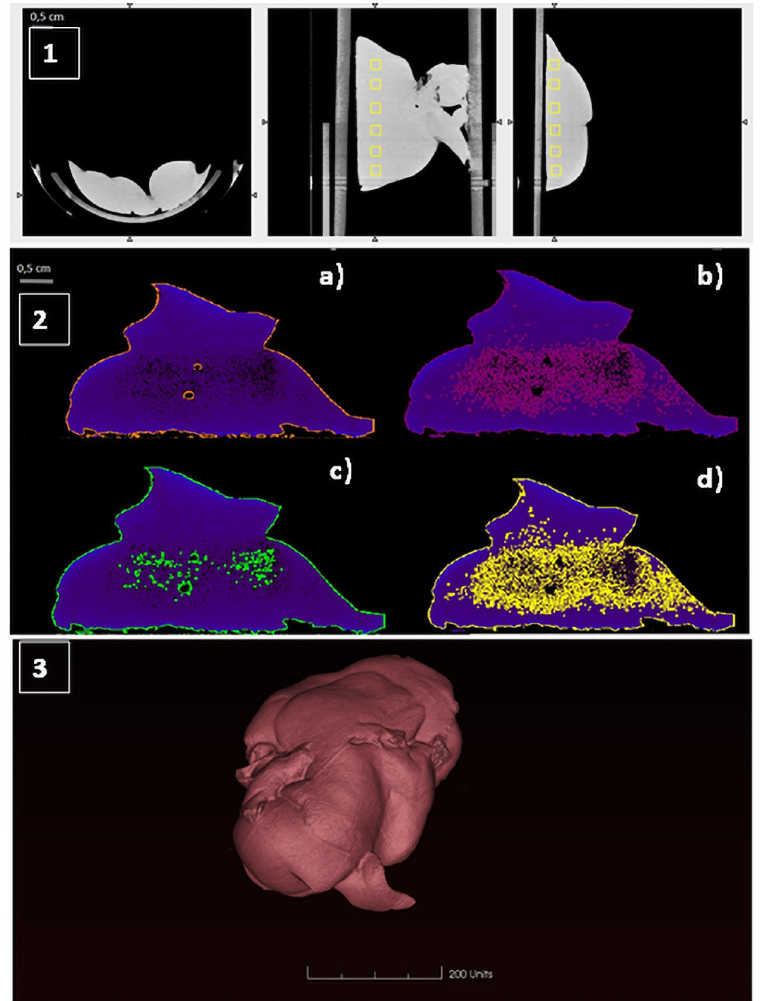
Fig 3. Micro-TC images of liver samples. (1) Hepatic parenchyma attenuation coefficient determination measured in HU in six different 8 mm 3 volumes of Interest (VOIs) (yellow squares). (2) Hepatic automatic segmentation by AMIDE Software. Segmentation was performed setting attenuation coefficient at 0 (a), 50 (b), 100 (c) and 120 (d)